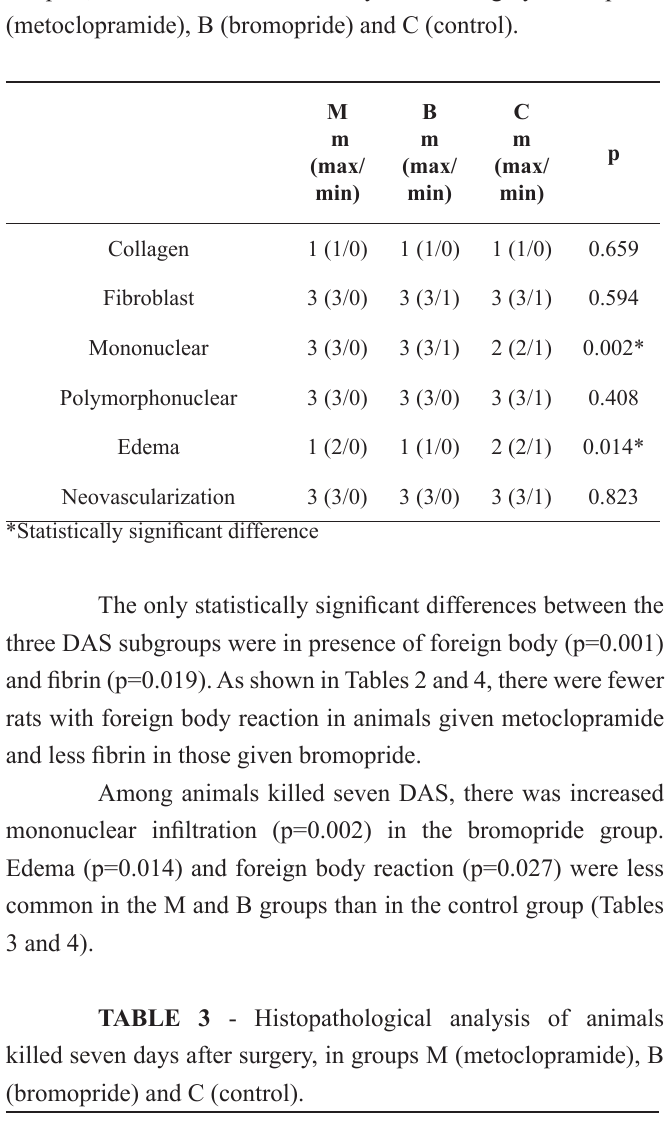
TABLE 4 - Histopathological analysis of animals killed seven days after surgery, in groups M (metoclopramide), B (bromopride) and C